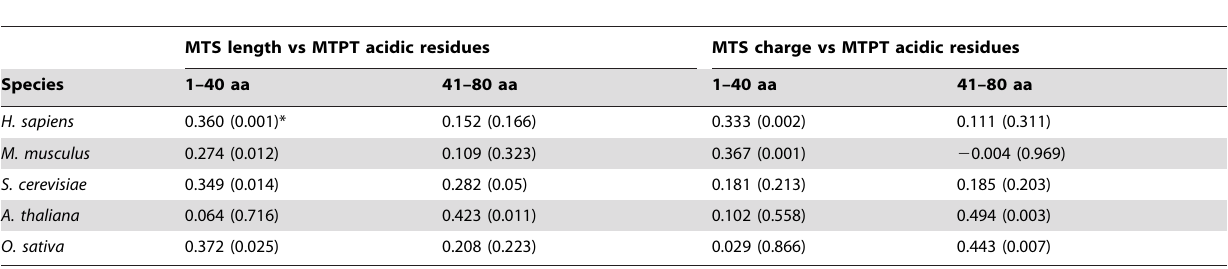
Table 1. Correlation analysis between MTS property and N-terminal mature sequence (MTPT) acidic residues relative to the cleavage